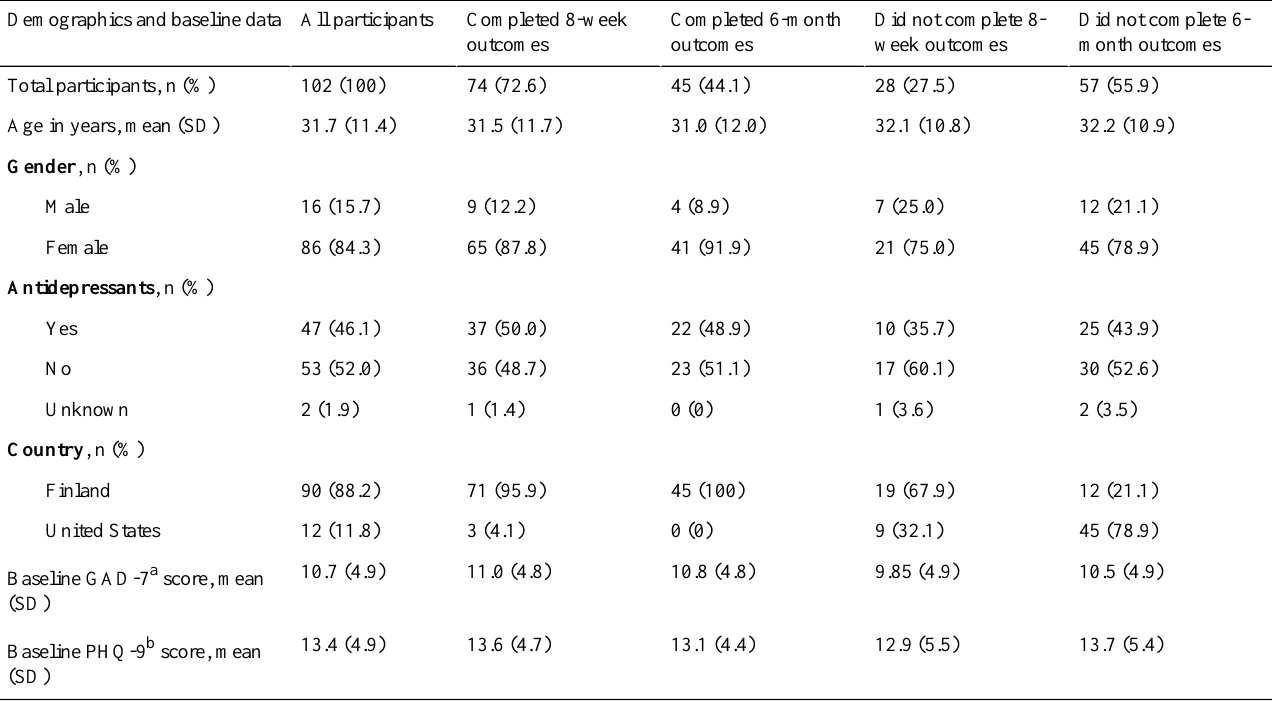
Table 2. Participant demographics and relevant baseline data for patients with Generalized Anxiety Disorder-7 outcomes available at 6-months postintervention.